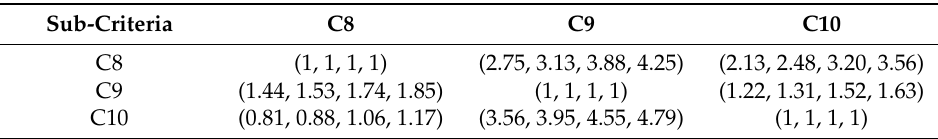
Table 11. Integrated fuzzy comparison matrix for Z4 sub-criteria weights.